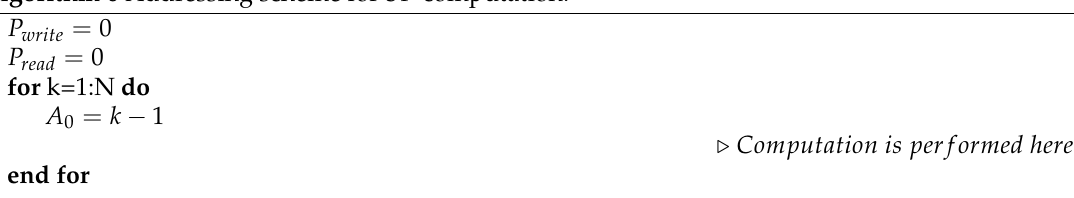
Algorithm 6 Addressing scheme for SP